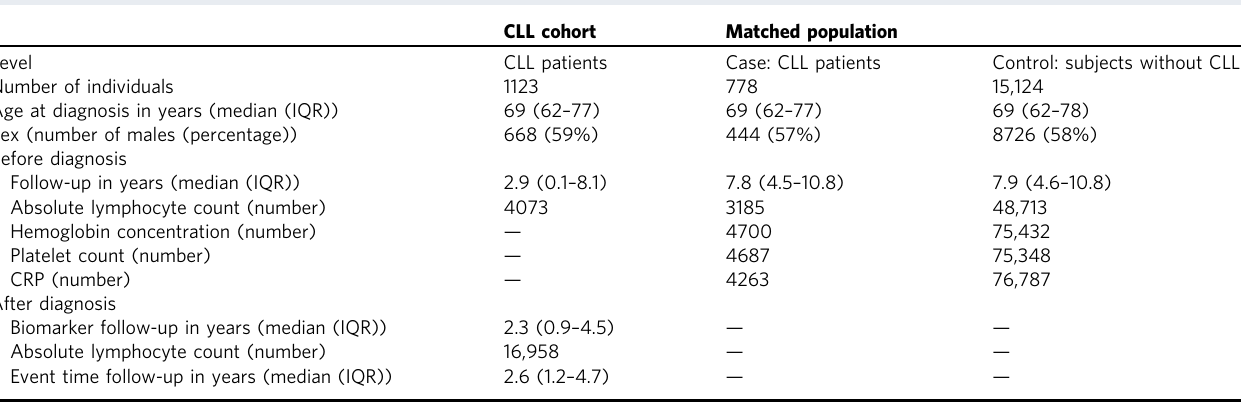
Table 1 Patient